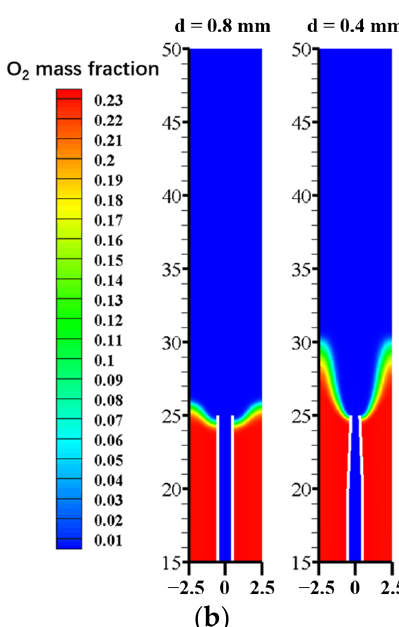
Figure 5. Mass fraction contours of H 2 and O 2 within the two combustors under V f = 25 m/s: ( a ) d = 0.8 mm, ( b ) d = 0.4 mm.